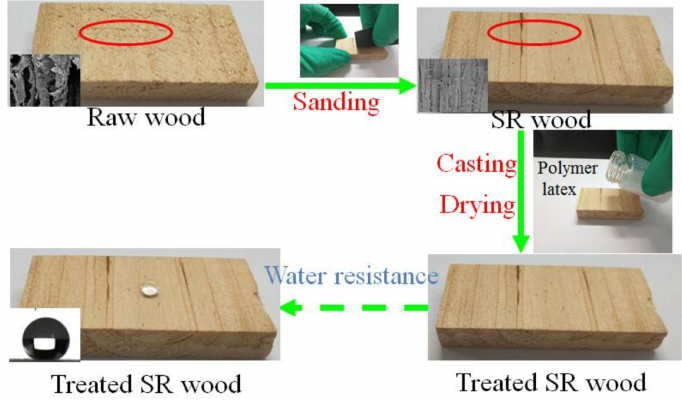
Scheme 1. Schematic procedure for the preparation of superhydrophobic